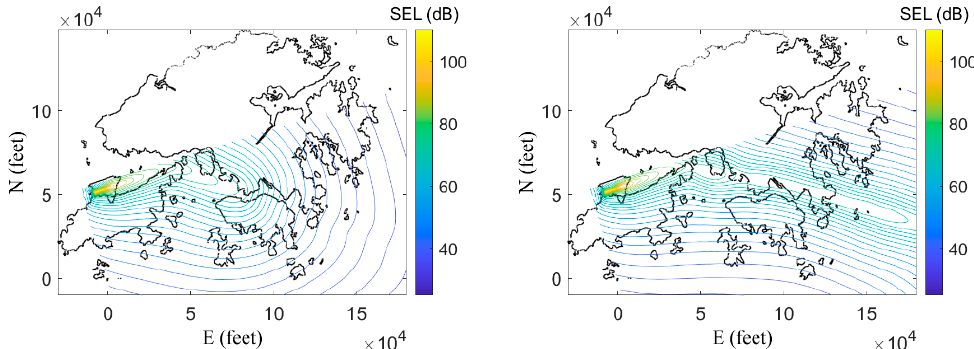
Figure 10. A330 aircraft departing from HKIA. Noise impact (SEL) generated by flight AD1 (left) and AD2 (right) over Hong Kong city.